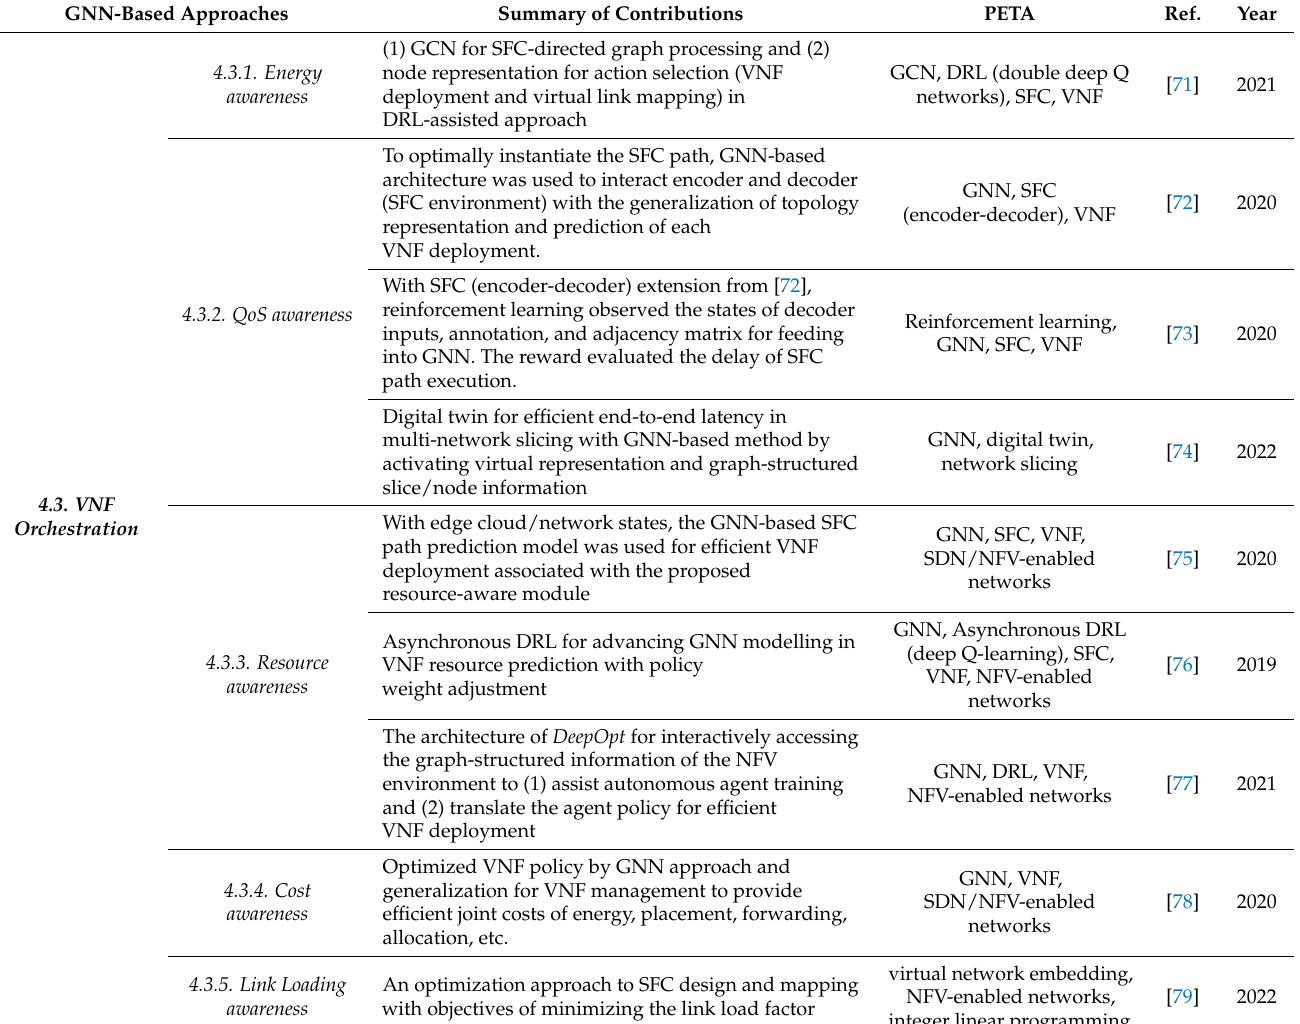
Table 5. Summary of Selected Works in GNN-Based VNF